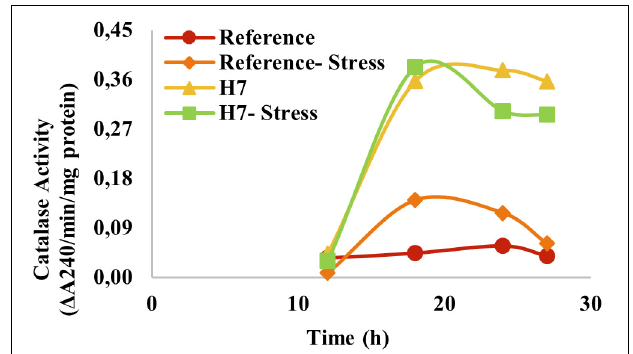
FIGURE 8 | Specific catalase activity ( (cid:49) A 240 /min/mg protein) of the reference strain and H7 in the absence and presence of 2-mM H 2 O 2 as the oxidative stress factor. The cultures were grown in YMM at 30 ◦ C and 150 rpm.